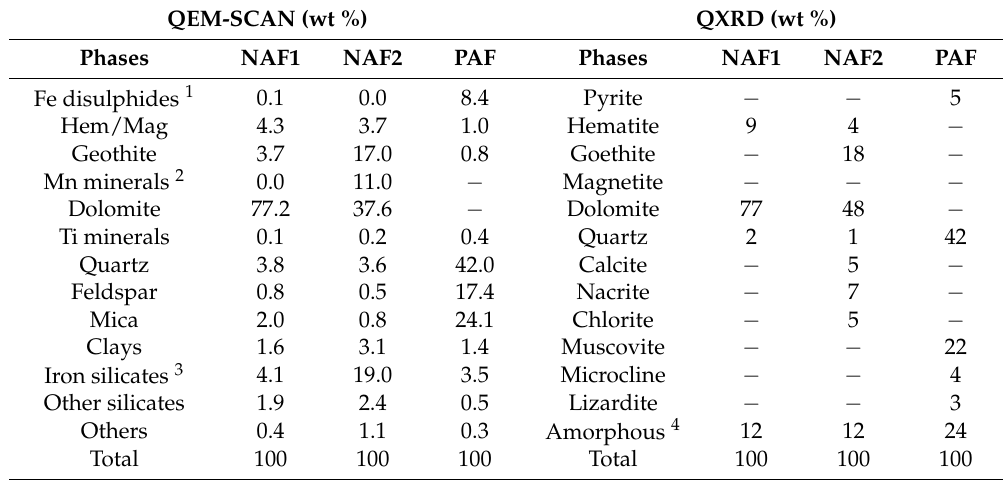
Table 4. QEM-SCAN and QXRD